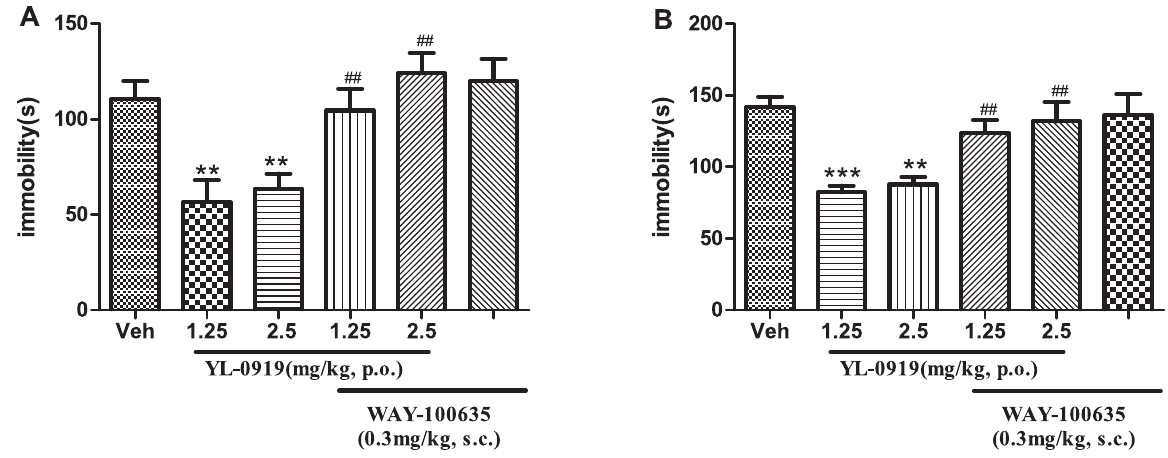
Figure 4. The effect of 5-HT 1A receptor in the antidepressant-like of YL-0919. Coadministration with WAY-100635 (0.3 mg/kg, s.c.) prevented YL-0919 (1.25, 2.5 mg/kg, p.o.)-induced reductions in the immobility time in TST (A) and FST (B) in mice. WAY, WAY-100635; YL, YL-0919. Mice received WAY-100635 and YL-0919 simultaneously; 60 min later, the animal were submitted to the forced swimming. Data are presented as means 6 SEM (n=10/group). ** p , 0.01, *** p , 0.001 versus vehicle, ## p , 0.01 versus the same dose of YL-0919.